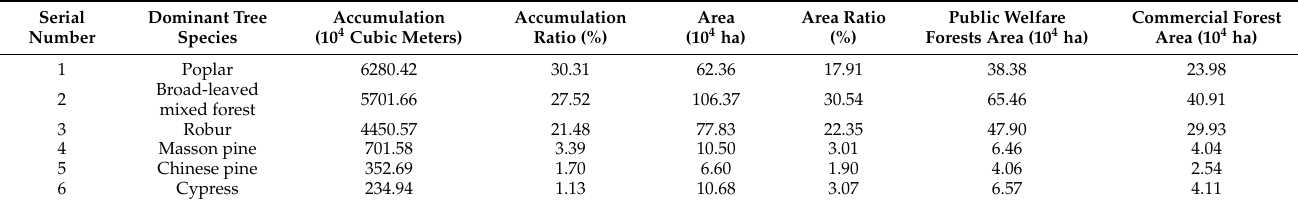
Table 1. Accumulation and area of dominant tree species in Henan